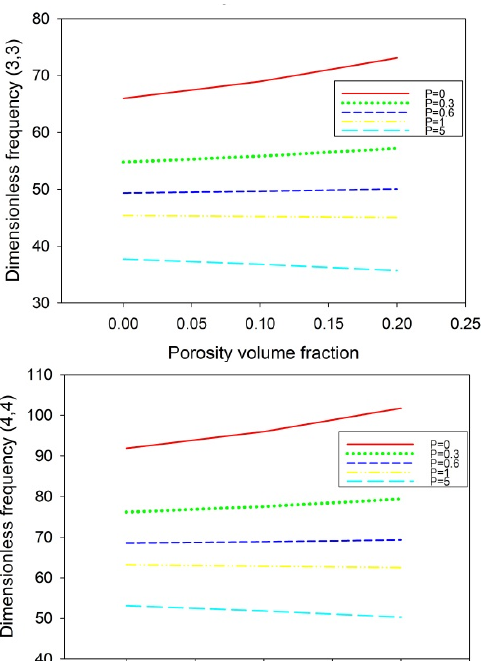
Figure 7 . Dimensionless frequency of FG porous spherical shell versus different power ‐ law indices for various porosity volume fractions: ( a ) FGM ‐ type 1, ( b ) FGM ‐ type 2.